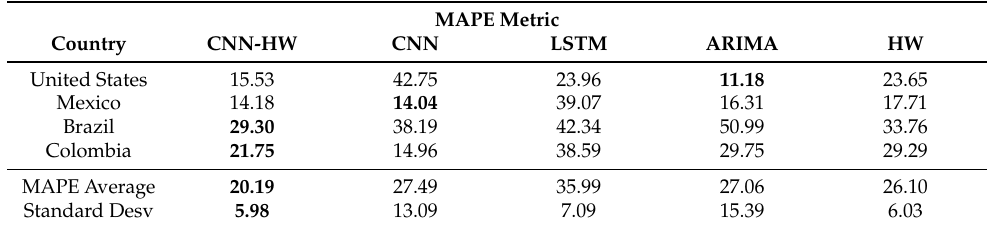
Table 3. The performance of the CNN–CT vs. individual methods. Best MAPE results are marked in